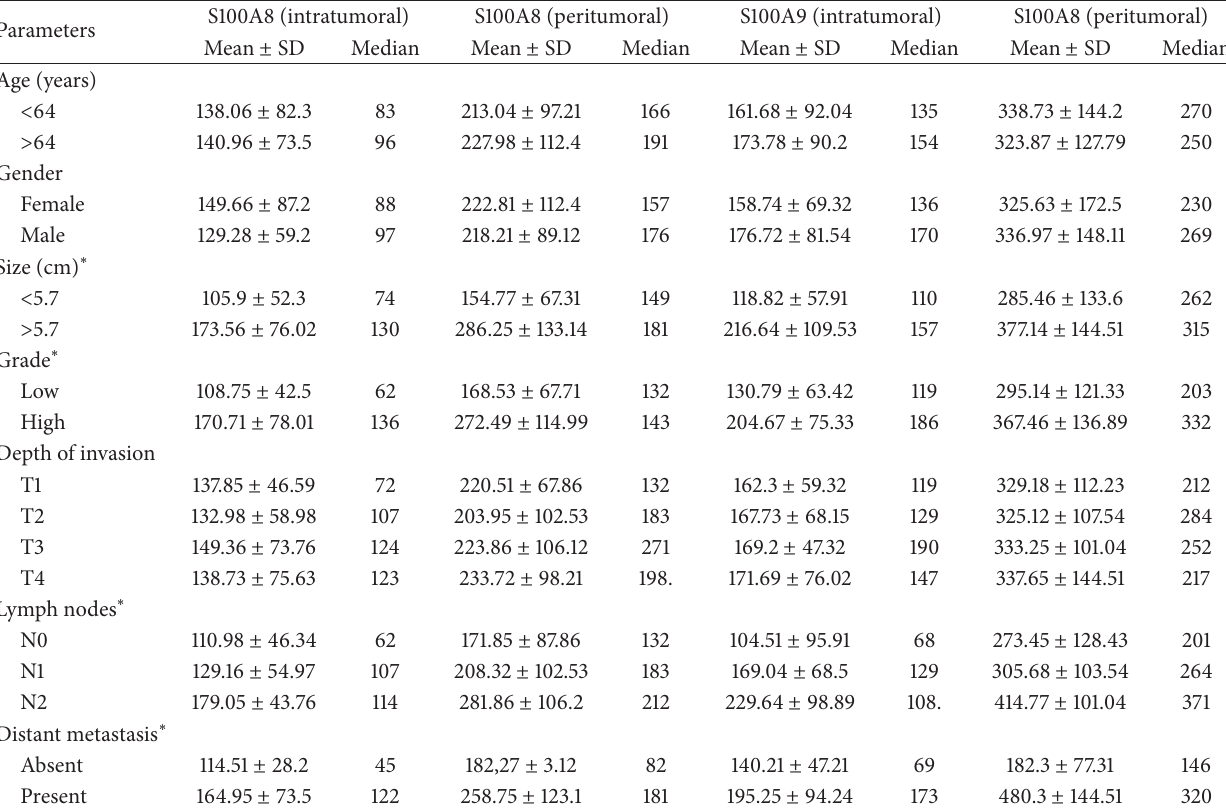
Table 1: Distributions of mean ± SD and median values of S100A8/A9 positive cells in both intratumoral and peritumoral areas, ∗ 𝑃 < 0.05 .